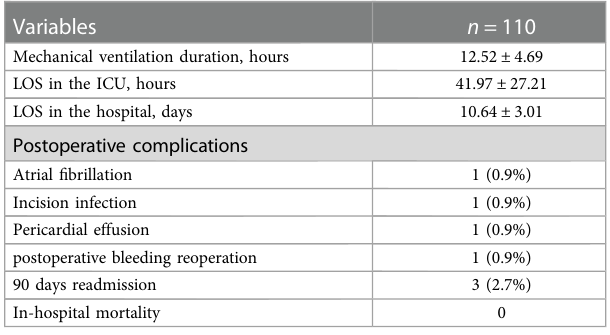
TABLE 5 Postoperative